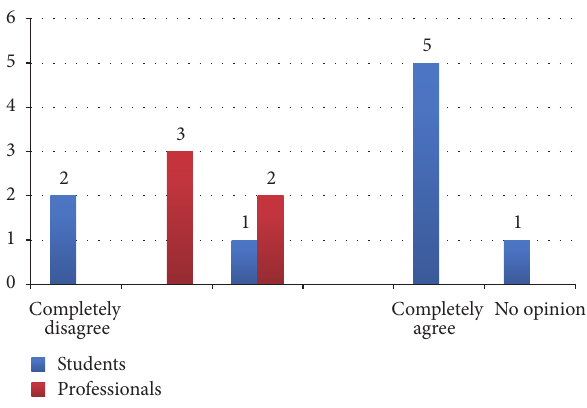
Figure 3: ECW/PUEA is very easy to learn.